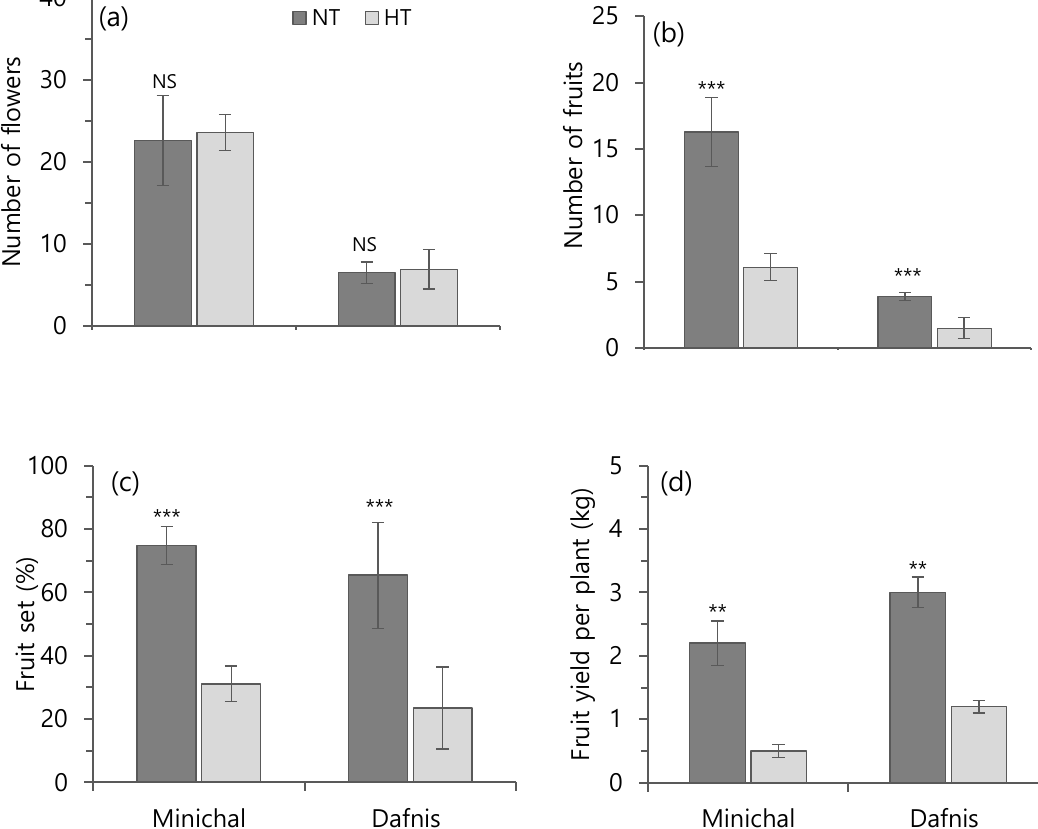
Figure 9. The number of flowers ( a ) and fruits ( b ), fruit set, ( c ) and fruit yield ( d ) of tomato cultivars grown in normal (NT) and high temperature (HT) greenhouses. Vertical bars represent ± SD (n = 6). NS, ** and *** indicate not significant and significant at the p ≤ 0.01 and p ≤ 0.001 levels in t -test,